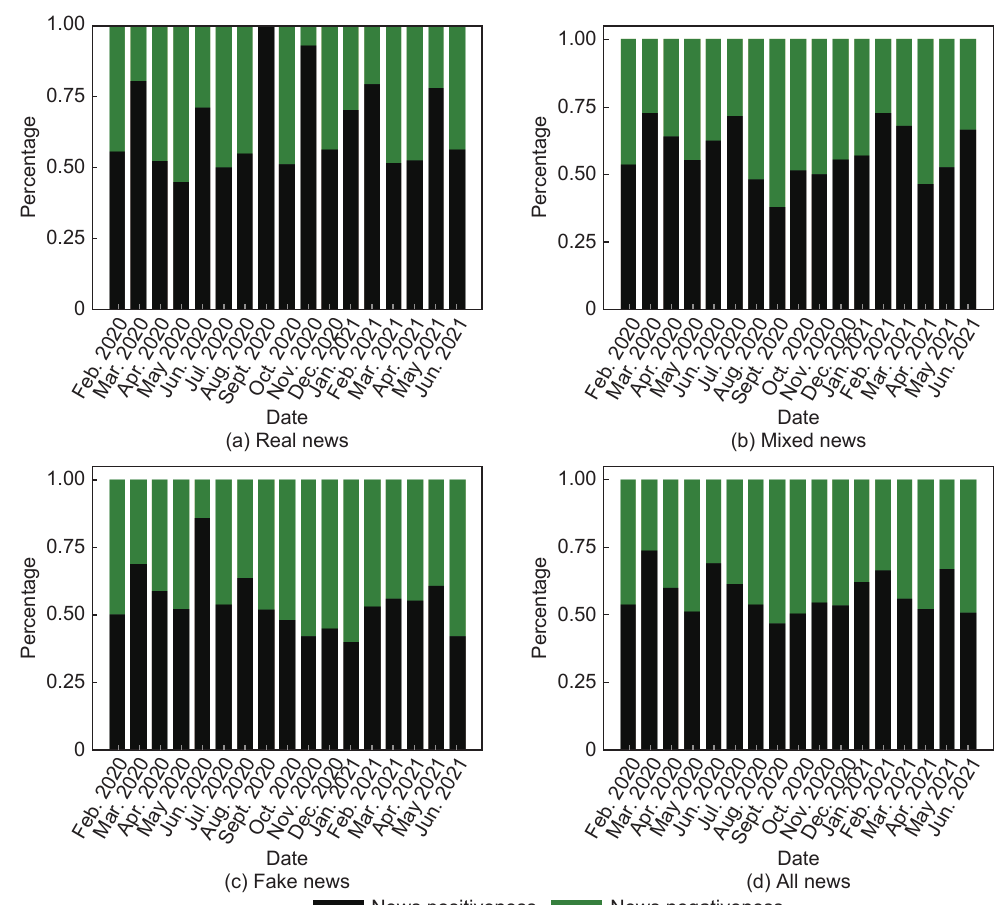
Fig. 5 Positiveness and negativeness of news about the COVID-19 for Feb. 2020–Jun. Table 5 Frequency of different types of news collected under various topics for Jan. 2020–Jun. 2021. Source Subject (an amount of news) politics (87), medical (29), fauxtography (17), entertainment (13), business (12), viral (5), phenomena (5), crime (5), history Real news (5), health (5) Mixed coronavirus (67), politics (48), health (32), facebook (29), public (19), medical (17), fact (16), checks (16), posts (10), budget news